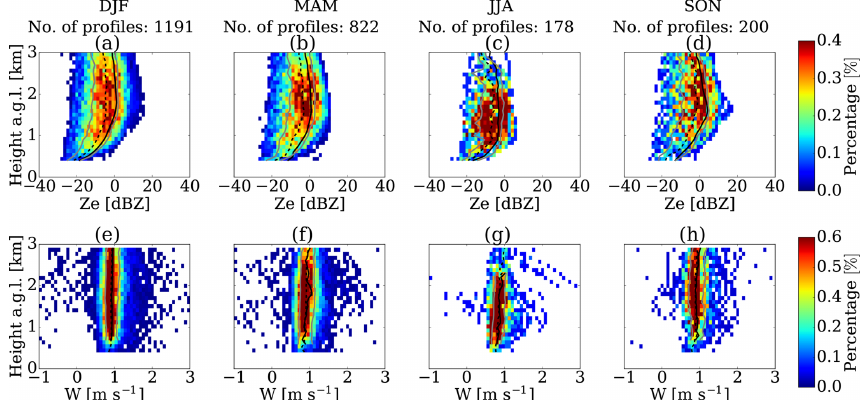
Figure 10. Same as Fig. 9, but for the Princess Elisabeth